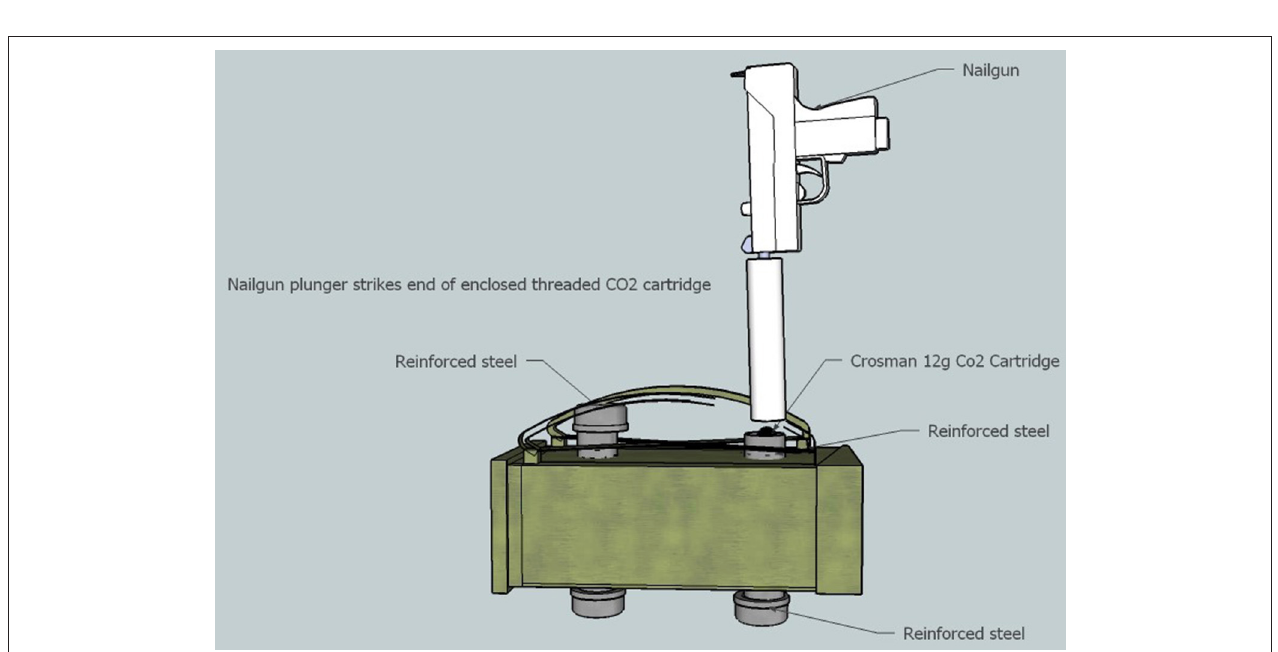
FIGURE 2 | Lateral view of blast chamber. When positioned within the chamber, the rounded end of the CO 2 cartridge sticks up approximately ½ cm out of the chamber to engage with the nail-gun safety sleeve. The re-enforced steel caps allow access to the blast chamber before and after each blast.